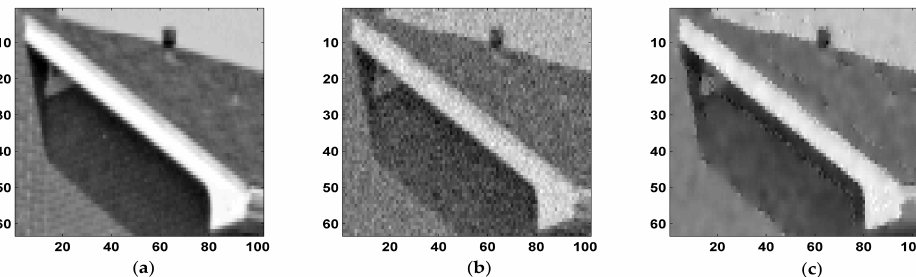
Figure 11. ( a ) House Image, ( b ) House Image with Gaussian white noise (Input PSNR = 24.59 dB), ( c ) Denoised Image with proposed Method (29.14